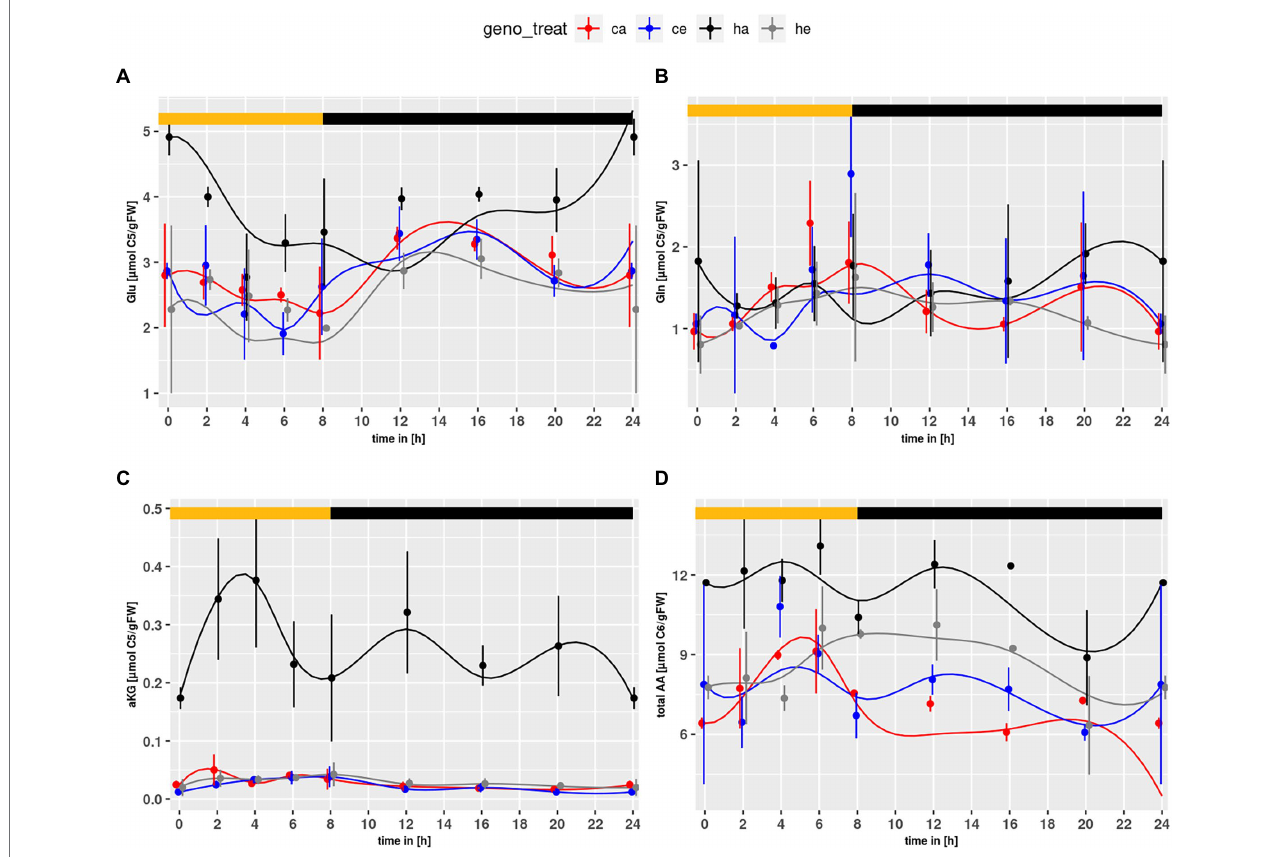
FIGURE 2 | Diurnal course of (A) glutamate, (B) glutamine, (C) α -ketoglutarate, (D) total amino acids. Col-0 ambient: red, Col-0 eCO 2 : blue; hpr1-1 mutant ambient: black, hpr1-1 mutant eCO 2 : grey. Shown are means with standard error ( n = 5). Lines represent the mean of 20 simulations. Light phase is indicated by yellow bar and dark phase indicated by black